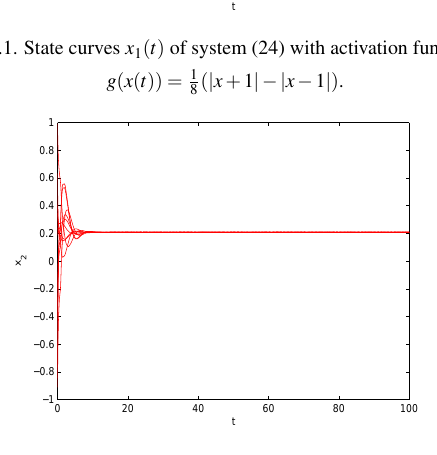
Fig.2. State curves x 2 ( t ) of system (24) with activation